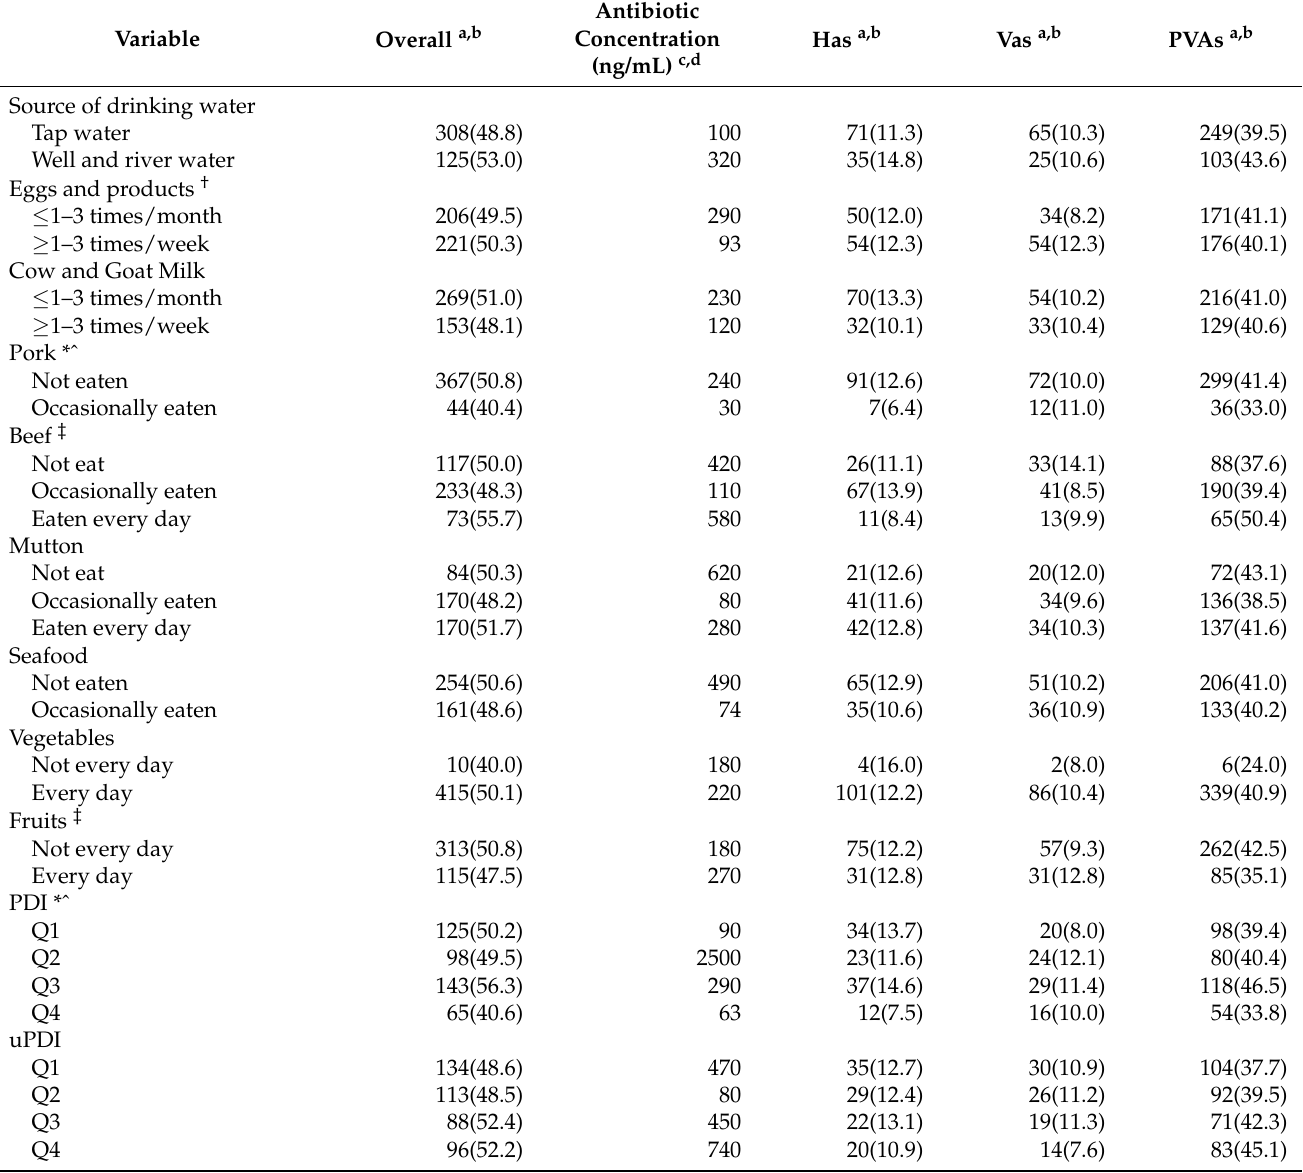
Table 3. Overall Detection Rate and Concentrations of Urinary Antibiotics in Relation to Selected